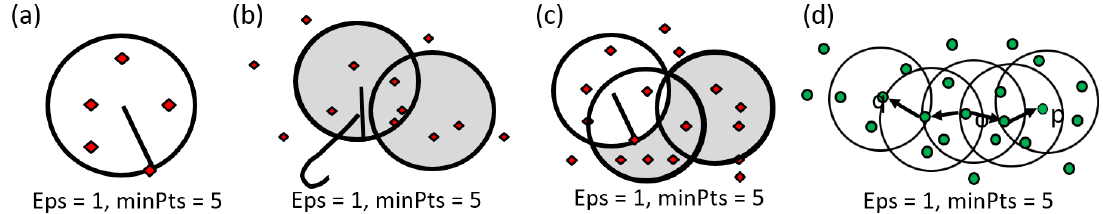
Figure 2. Visualize the steps for density-based spatial clustering of applications with noise (DBSCAN). ( a ) Parameter illustration; ( b ) Direct density can approach; ( c ) Indirect linkage by density; and ( d ) The linkage by density.